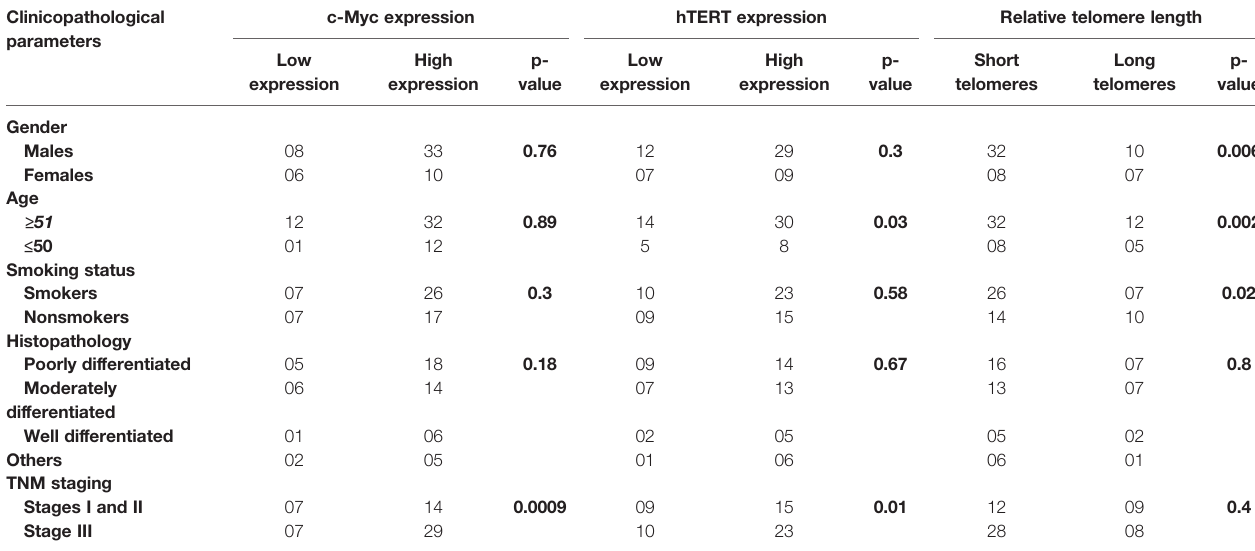
The bold values represents that they are statistically signi fi